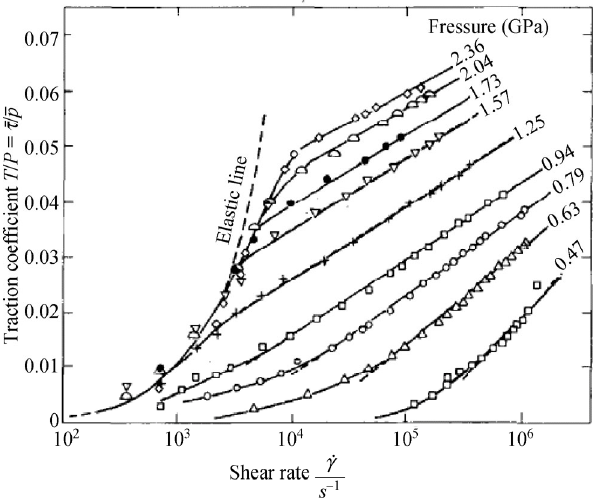
Fig. 5 Isothermal friction coefficient versus shear rate for a hydrocarbon lubricant in an EHD contact. Reproduced with permission from [59]. Copyright I.Mech.E.,